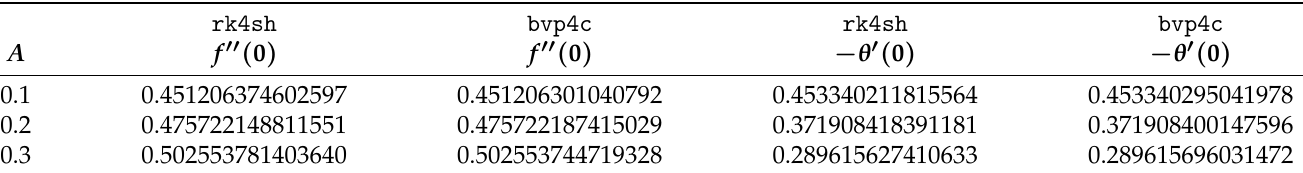
Table 2. Reliance on numerical integration for static wedge λ = 0 and η ∞ = 5.